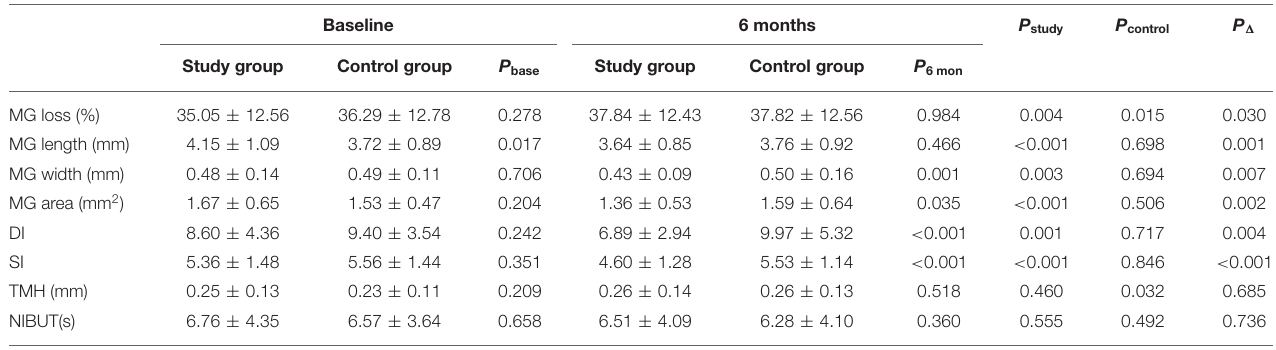
TABLE 1 | The changes in parameters before and at 6 months after cataract surgery in both groups. Baseline 6 months P study P control P 1 Study group Control group P base Study group Control group P